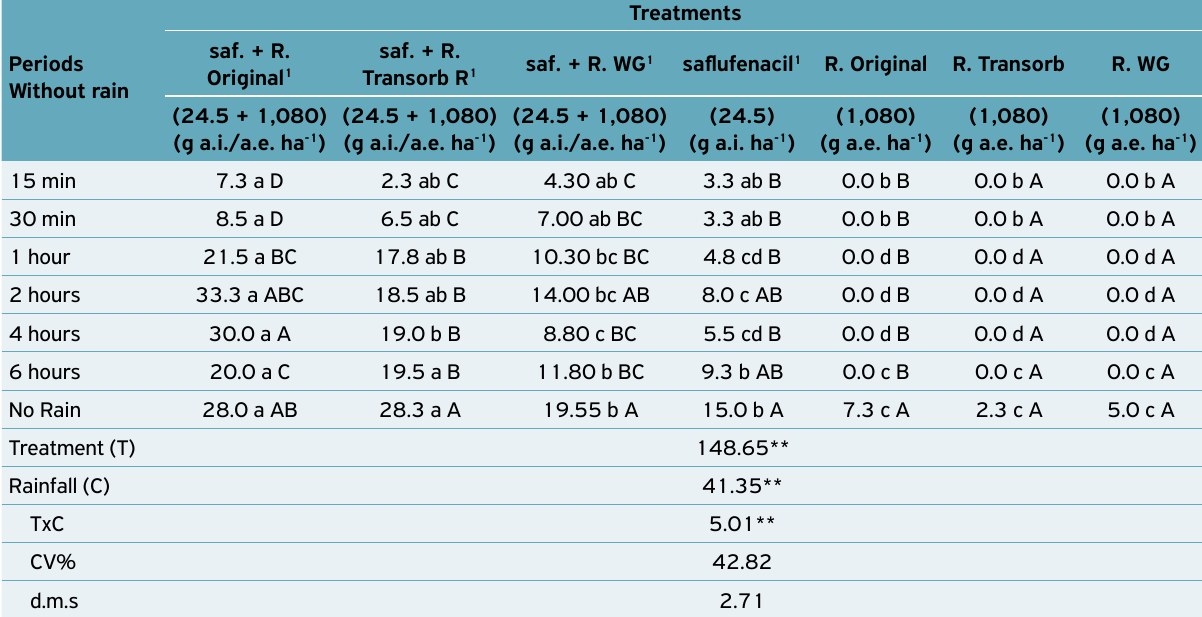
Table 1. Mean values for percentage of control of Brachiaria decumbens at 4 DAA obtained by the unfolding of degrees of freedom of the interaction between herbicides and periods without rain after the application of herbicides.